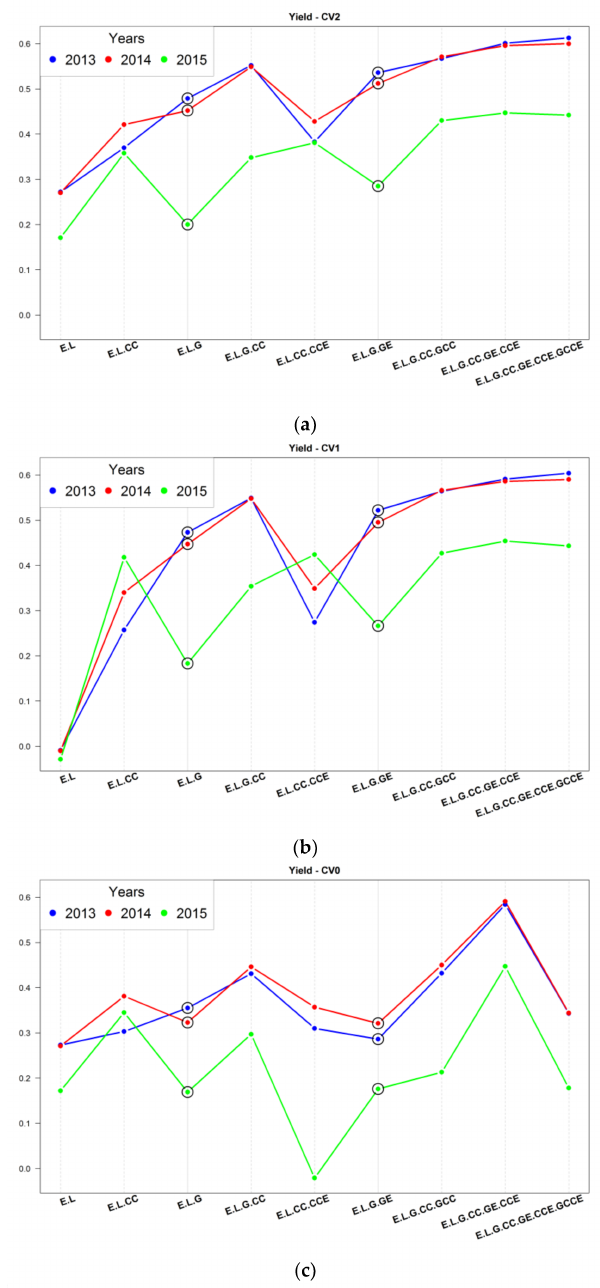
Figure 3. Average prediction accuracy obtained for the nine models for yield using the CV2 ( a ); CV1 ( b ); and CV0 ( c ) cross-validation schemes. The three different colors represent the years for which the prediction was carried out. E = environment, L = line, G = genotype, GE = genotype × environment interaction, CC = canopy information, CCE = canopy × environment interaction, GCC = genotype × environment × canopy interaction, GCCE = genotype × canopy × environment